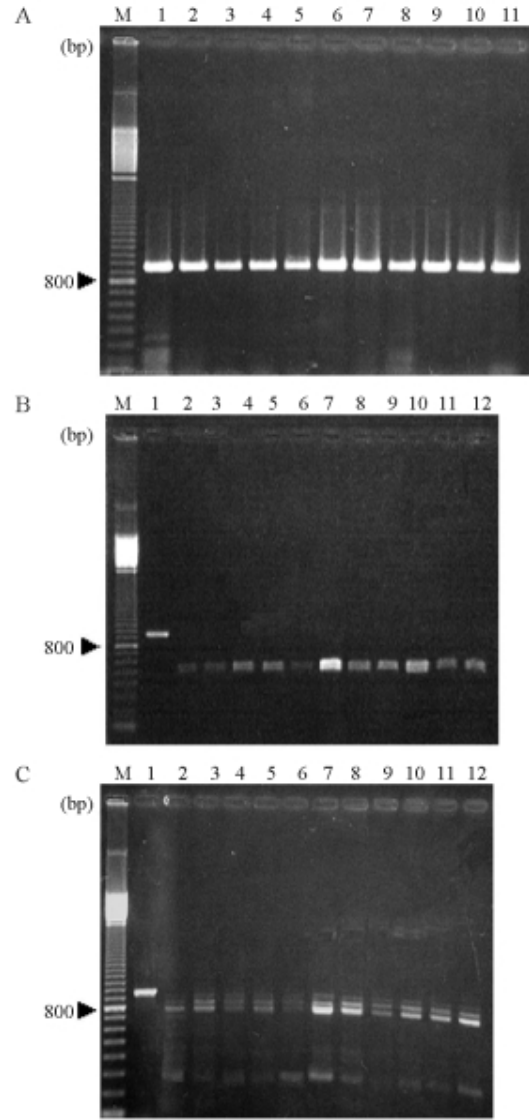
Figure5 -PCRproductsfromtheprimersdirectedtothegene psn (A)and strains P. CE 882R (line 1); YP 882/32R (line 2); P. Exu 340/RWB (line 3); YP 340/10W (line 4); YP 340/15W (line 5); P. Peru 375R (line 6); YP 375/4RW (line 7); YP 375/4RWB (line 8); YP 375/4WRP (line 9); YP 375/16WRP (line 10); YP 375/22W (line 11); M = 100 bp DNA ladder; and digestion of the PCR products with Bcl I (B) and EcoR V (C): same cultures lines 2-12; undigested PCR from YP 882/32R: line 1; M = 100 bp DNA